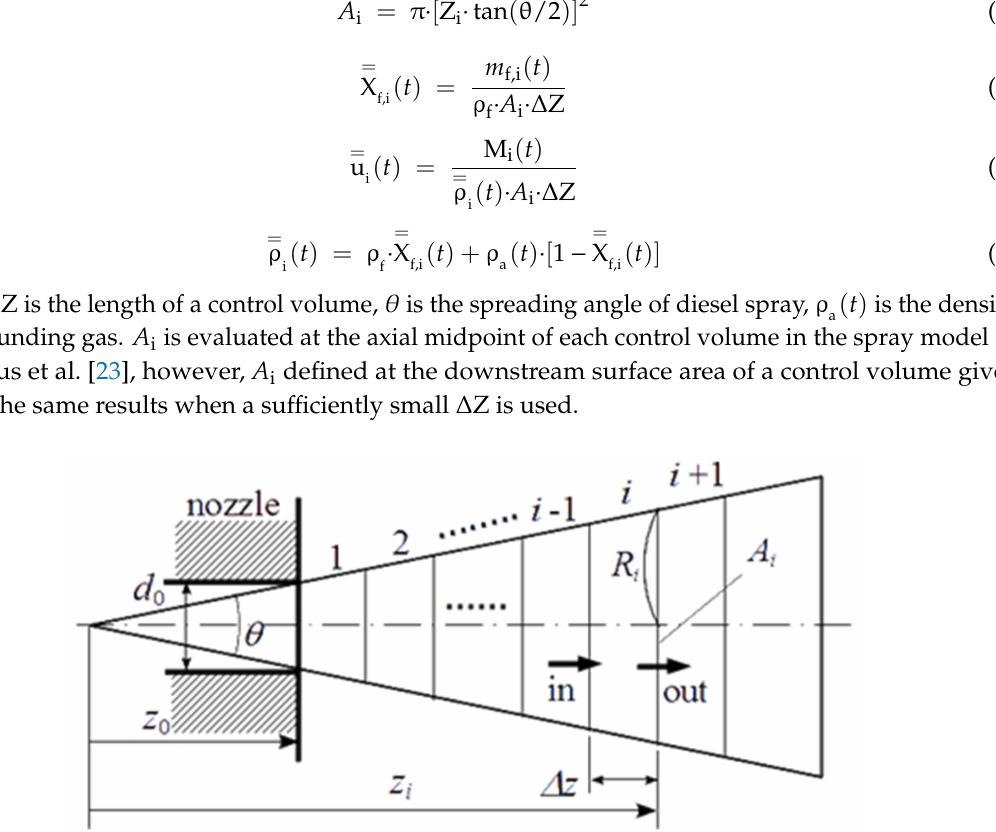
Figure 1. Schematic diagram of one-dimensional discrete diesel spray